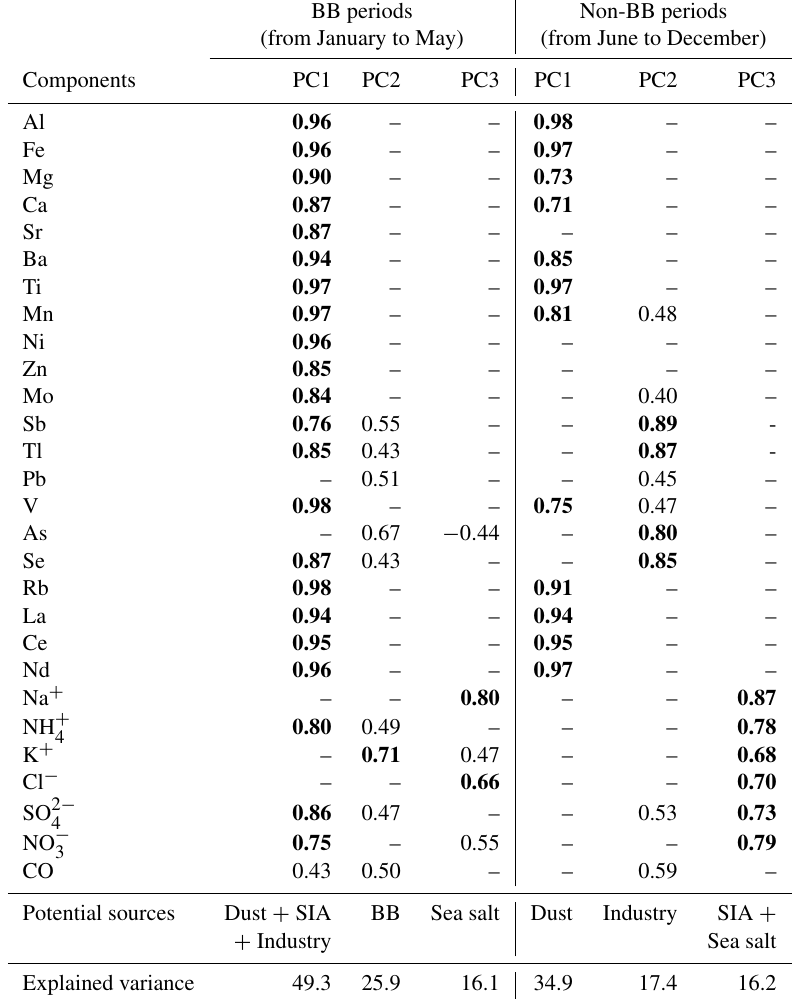
Table 1. Summary of principal component analysis for aerosol species and carbon monoxide observed at Mount Hehuan. Factor loadings lower than ± 0 . 4 are not given. Factor loadings lower than ± 0 . 7 are marked in